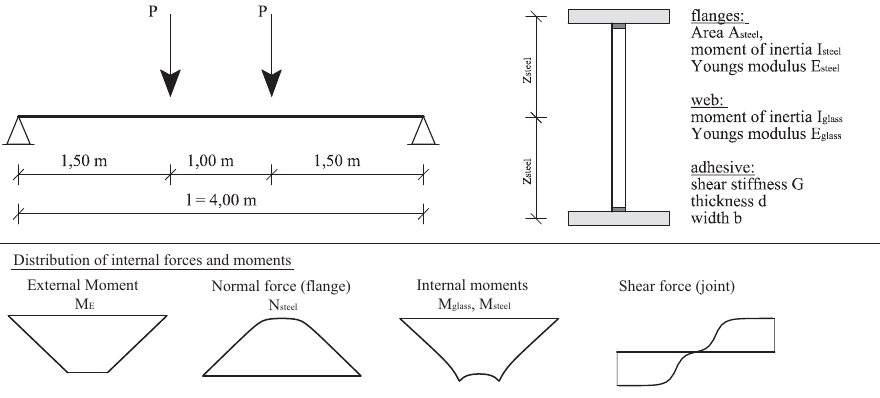
Figure 7: structural system and distribution of internal